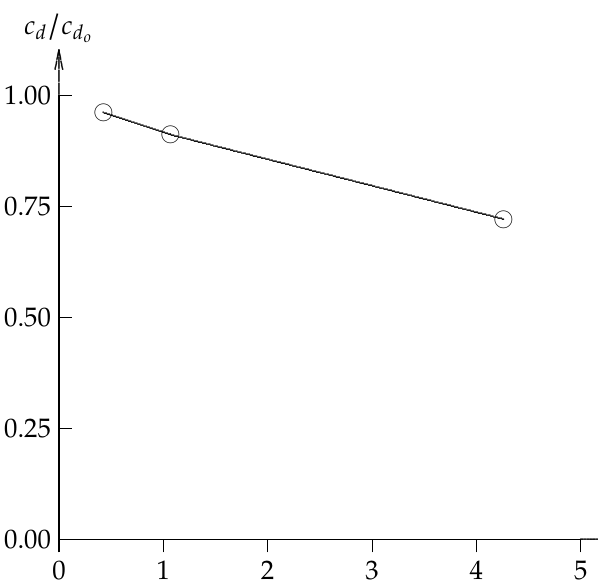
Figure 44. Wave drag versus dimensionless. Figure 40. Wave drag versus